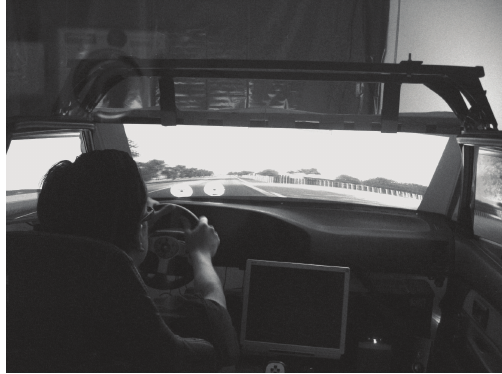
Figure 2: The driving simulation